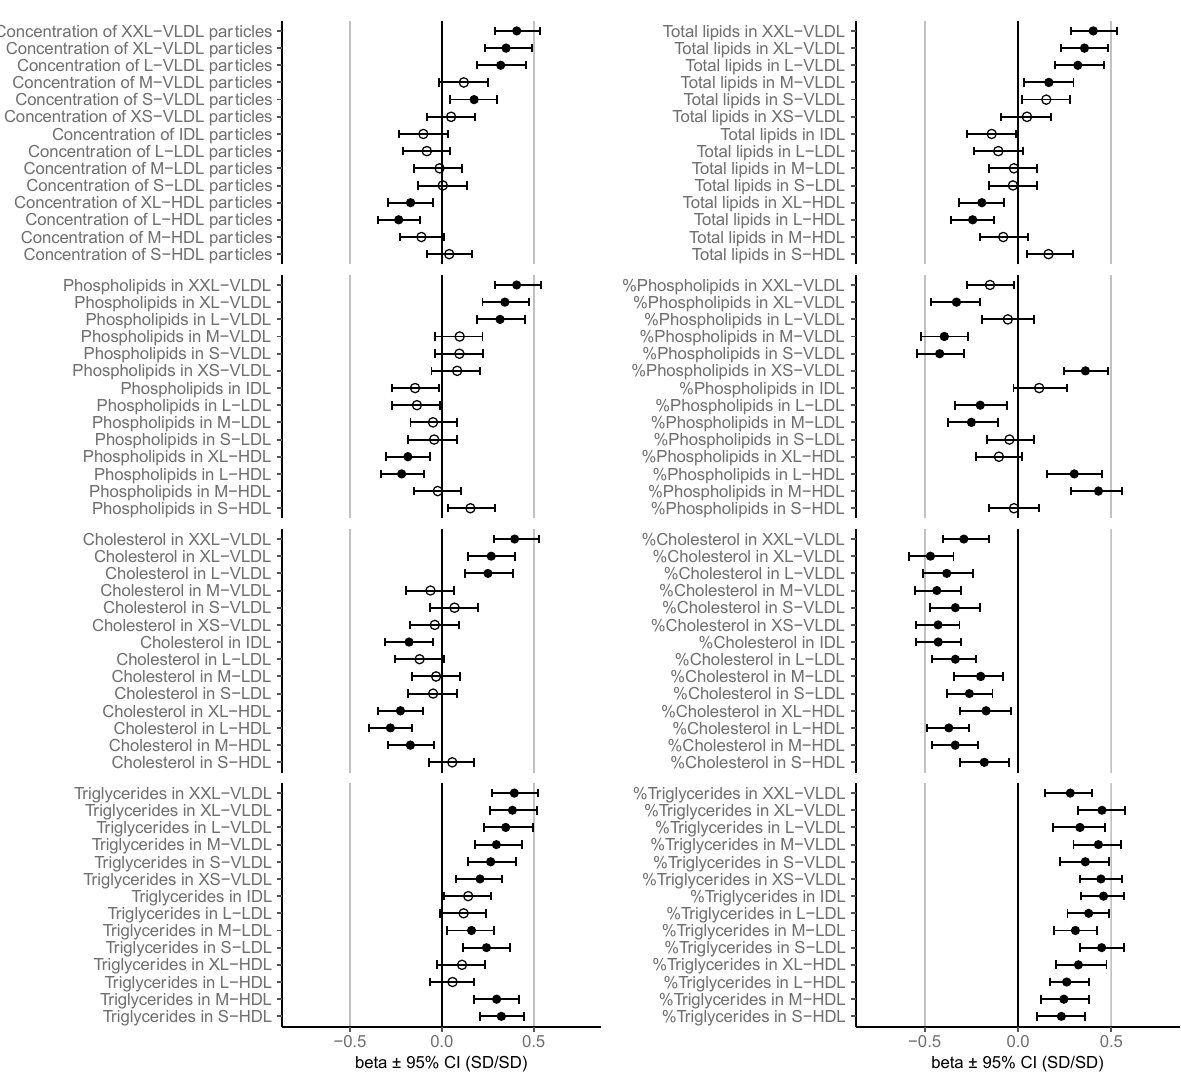
Figure 2. Associations between insulin resistance and lipoprotein lipids. Regression β -estimates with 95% confidence intervals are given for each association adjusted for BMI class and gestational age at sampling. Filled circles denote significant ( p < 0.01) and open circles nonsignificant associations. S/M/L: small/medium/large, XS: very small, XL: very large, XXL: extremely large.